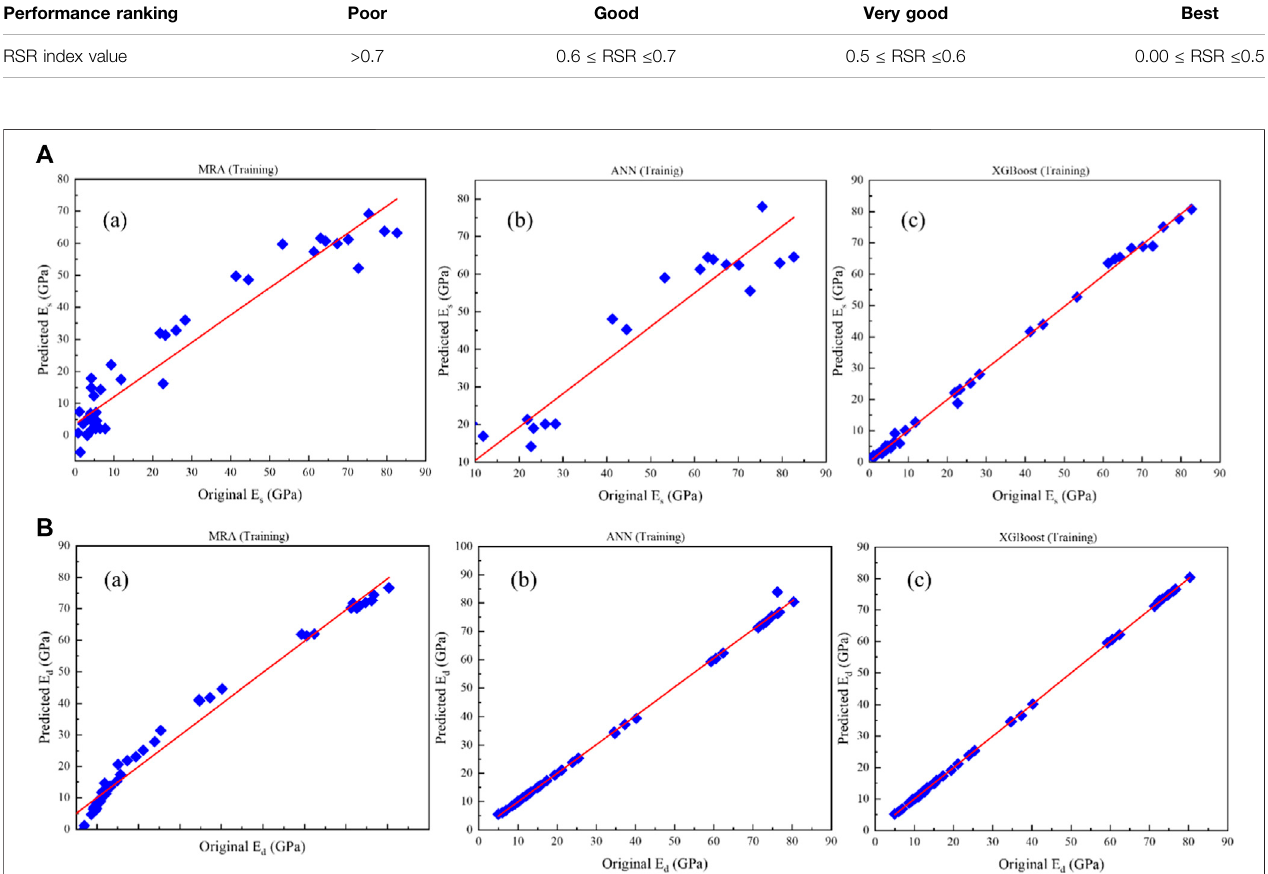
FIGURE 6 | Results of (A) E s and (B) E d prediction against original data in the training stage: (a) MLR, (b) ANN, and (c) XGBoost.